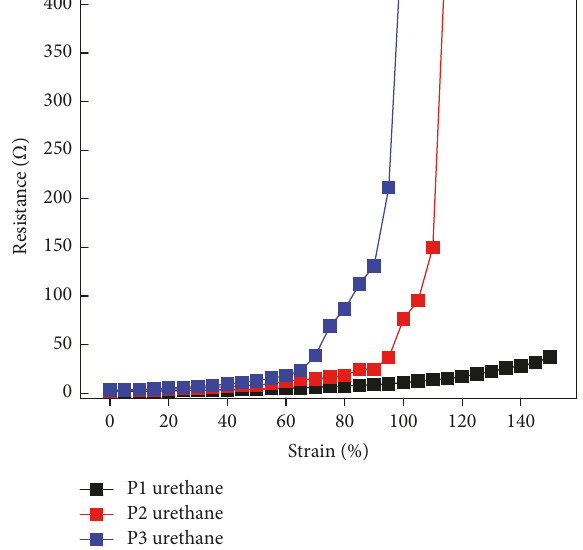
Figure 8: Electrical resistance versus tensile strain plot of unpat- terned Ag electrode films.